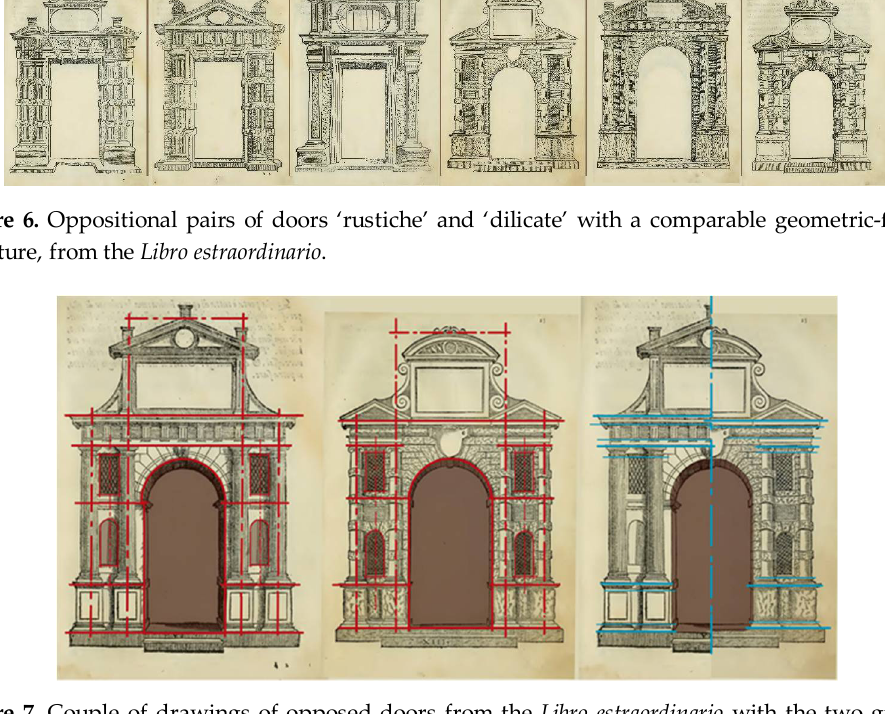
Figure 7. Couple of drawings of opposed doors from the Libro estraordinario with the two graphic readings of the neutral term of the semiotic square related to the opposition Rustiche/Dilicate : in red two schemes related to the ‘Compositional Geometry’, in cyan the comparison between the two examples on the ‘Structural